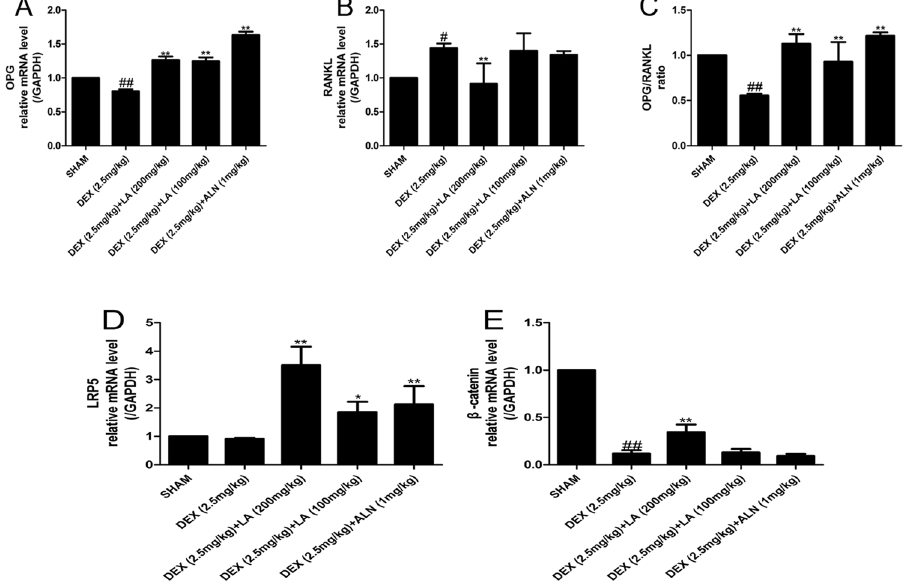
Figure 3. The mRNA expression levels of OPG and RANKL on the femur. The mRNA expression levels were measured by qRT-PCR for OPG ( A ), RANKL ( B ). OPG/RANKL ratio ( C ). Data were the means ± SD (n = 6 for each group). # P < 0.05 and ## P < 0.01, vs. the SHAM group. * P < 0.05 and ** P < 0.01, vs. the DEX group. The mRNA expression levels of the LRP5/beta-catenin pathway on femur. The mRNA expression levels were measured by qRT-PCR for LRP5 (D), beta-catenin (E). Data were the means ± SD (n = 6 for each group).